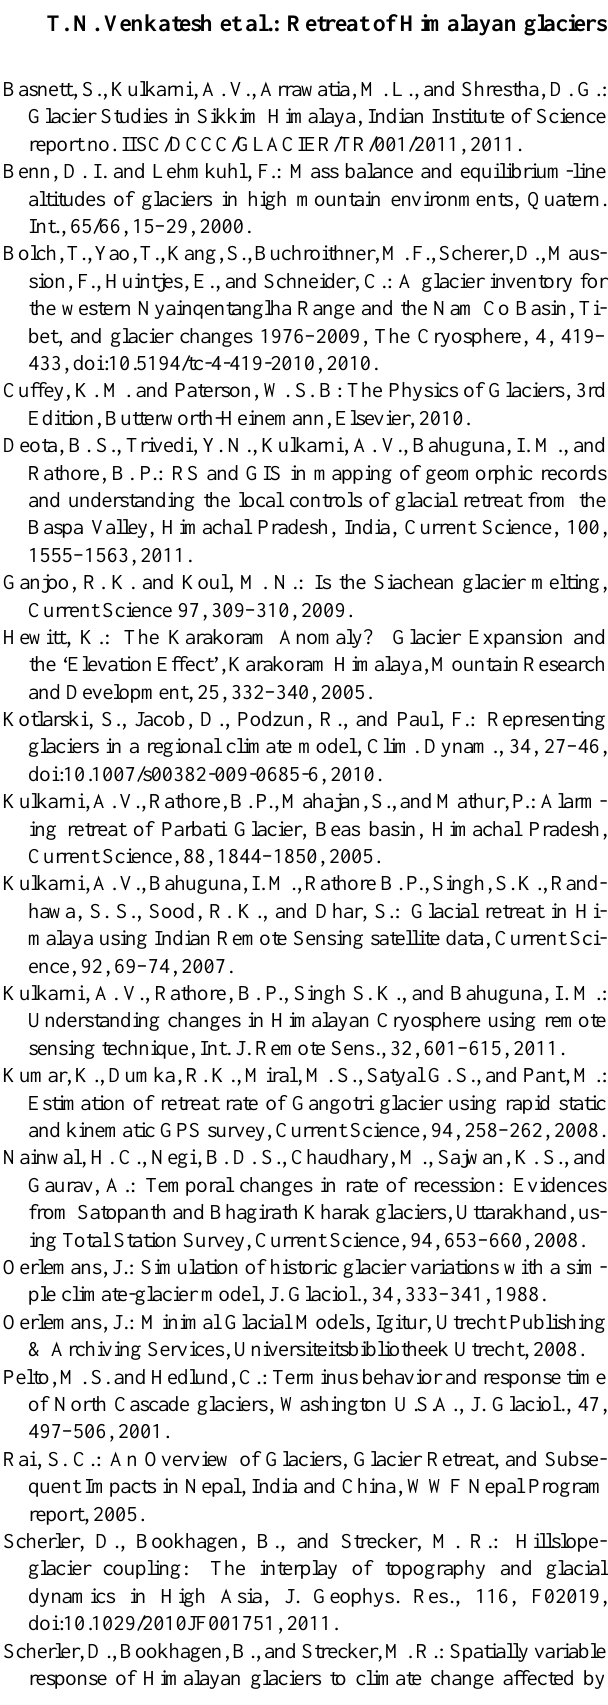
with retreat data over a shorter time-period, the distributions are well